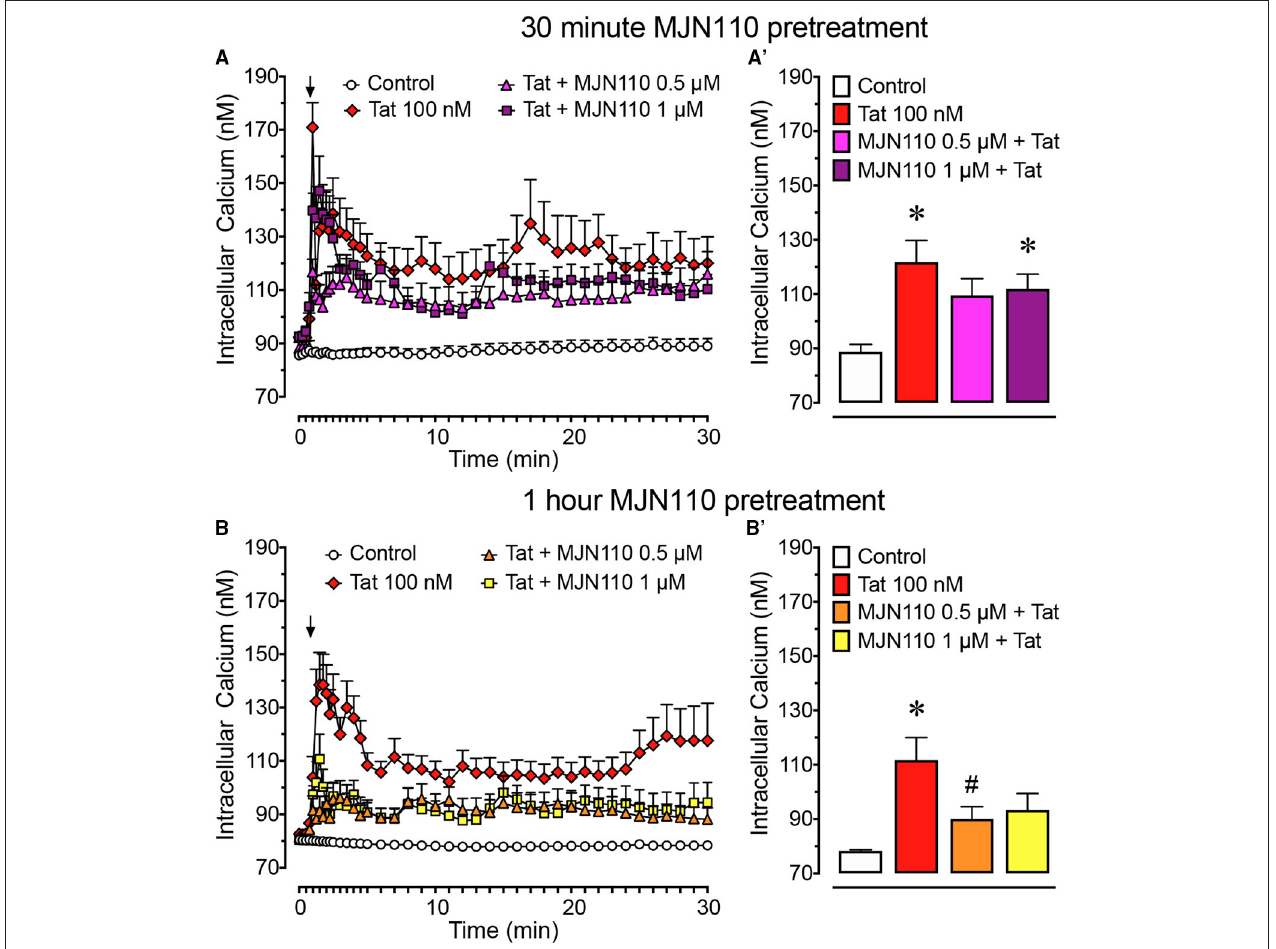
FIGURE 2 | Primary frontal cortex neuron cultures (DIV 7-11) were untreated or pre-incubated for (A) 30min or (B) 1h with different concentrations of MJN110 before [Ca 2 + ] i imaging began. [Ca 2 + ] i levels were plotted over a 30-min time period with Tat 100nM being applied at the 1-min mark (arrow). (A) Pre-incubation of MJN110 for 30min prior to Tat application was not able to inhibit significant increases in [Ca 2 + ] i induced by Tat when observed across a 30-min time period. (A’) The [Ca 2 + ] i levels are summarized for the last 10min of calcium assessment and indicate that none of the MJN110 concentrations is able to inhibit Tat-induced increases in [Ca 2 + ] i levels. (B) Pre-incubation of MJN110 for 1h prior to Tat application inhibited Tat-associated [Ca 2 + ] i upregulation over a 30-min time period. (B’) The [Ca 2 + ] i levels are summarized for the last 10min of calcium assessment and indicate that MJN110 0.5 µ M was able to significantly inhibit Tat-induced [Ca 2 + ] i increases. Data are mean ± SEM. Statistical significance was determined using ANOVA and Bonferroni correction where applicable. An alpha level of p < 0.05 was considered significant for all statistical tests. * p < 0.05 vs. Control; # p < 0.05 vs. Tat 100nM.